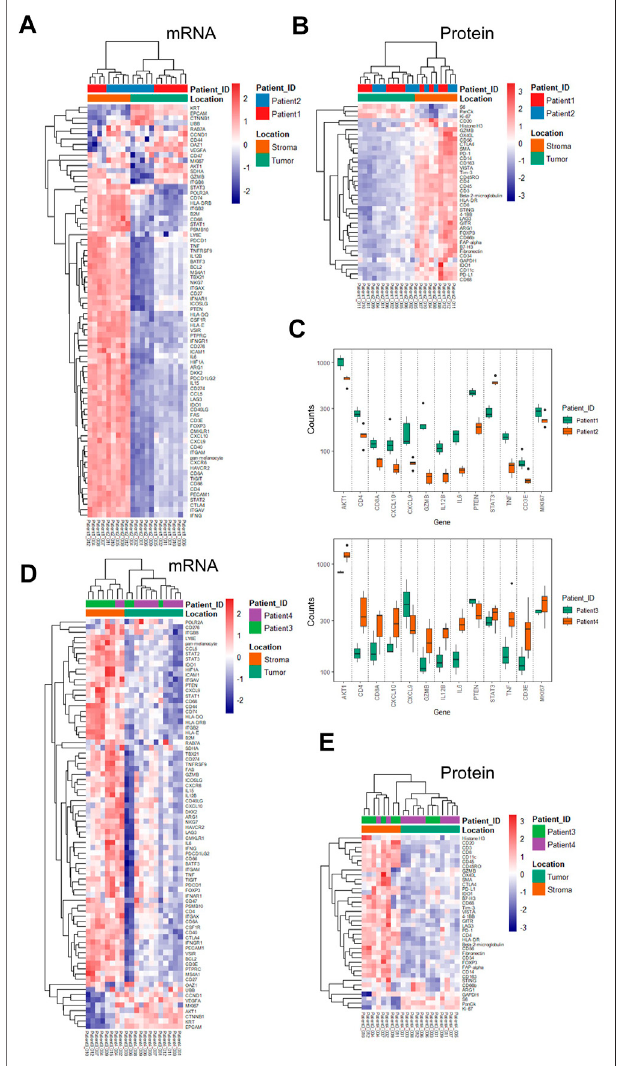
FIGURE 2 | Unsupervised hierarchical clustering of mRNA and protein forROIsfromchemotherapy-andcombinationaltherapy – treatedpatientsand differentially expressed genes. (A) mRNA-based clustering of tumor and stroma ROIs of chemotherapy-treated patients 1 and 2. (B) Protein- based clustering of tumor and stroma ROIs of chemotherapy-treated patients 1and2. (C) DifferentialmRNAexpressioninthetumorROIsbetweenpatient1 and patient 2 ( p -values were adjusted, and the cut-off was set to 0.05). (D) mRNA-based clustering of tumor and stroma ROIs of combinational therapy – treated patients 3 and 4. (E) Protein-based clustering of tumor and stroma ROIs of combinational therapy – treated patients 3 and 4. Color bars are grouped based on ROI categories (tumor/stroma) and patient IDs,